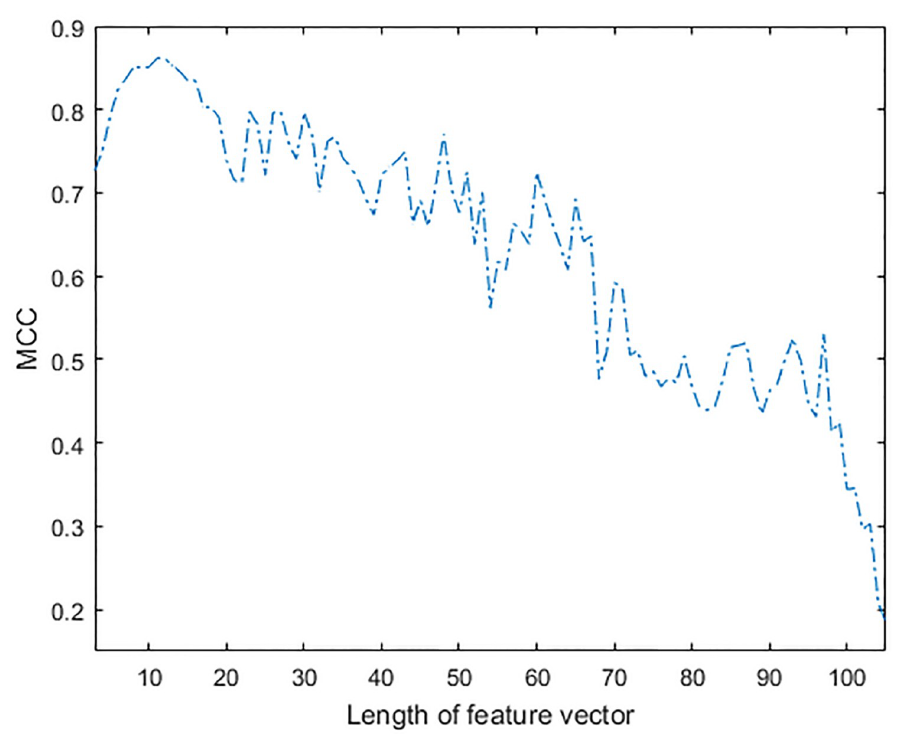
Fig 7. Effect of feature vector length on MCC of